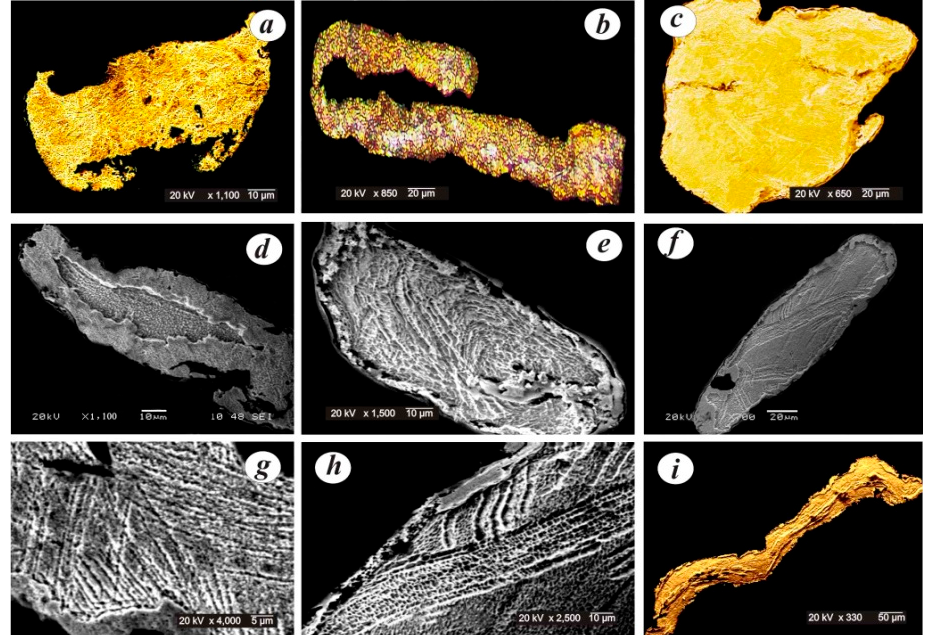
Figure 2. Internal structures of placer flake gold of the Precambrian stage of ore formation: ( а ) primary recrystallization with deformation lines; ( b ) secondary recrystallization; ( c ) complete recrystallization on high-grade gold with fine deformation lines; ( d ) thick high-grade shell (20–30 µ m) on low-grade gold; ( e,f ) high-grade shells on gold particles with deformation lines; ( g – i ) multidirectional deformation lines at different magnifications.